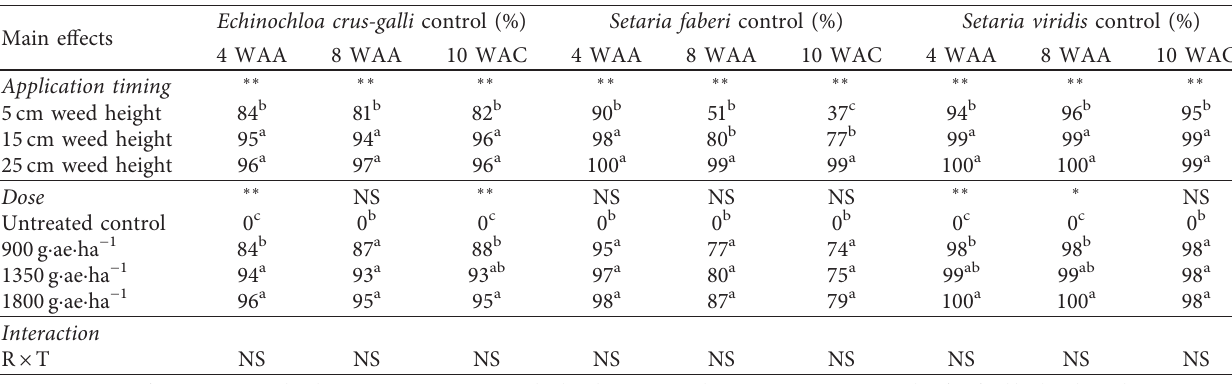
Table 4: Significance of main effects and interaction for percent visible control of Echinochloa crus-galli , Setaria faberi , and Setaria viridis in soybean treated with glyphosate/dicamba at various POST timings at four Ridgetown, ON, sites (2016–2018) and two Exeter, ON, sites